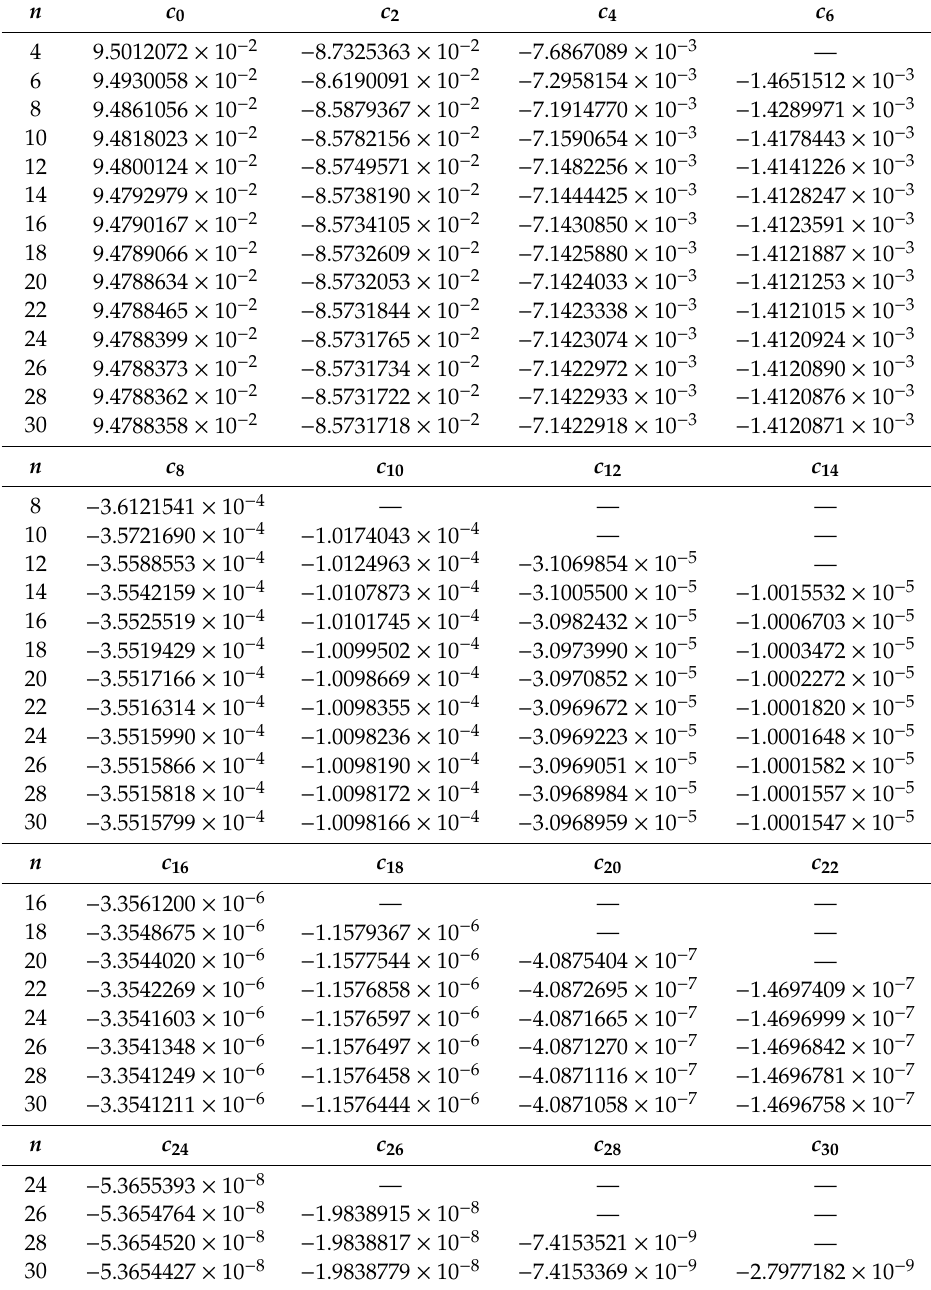
Table 2. The values of c 0 – c 6 , c 8 – c 14 , c 16 – c 22 and c 24 – c 30